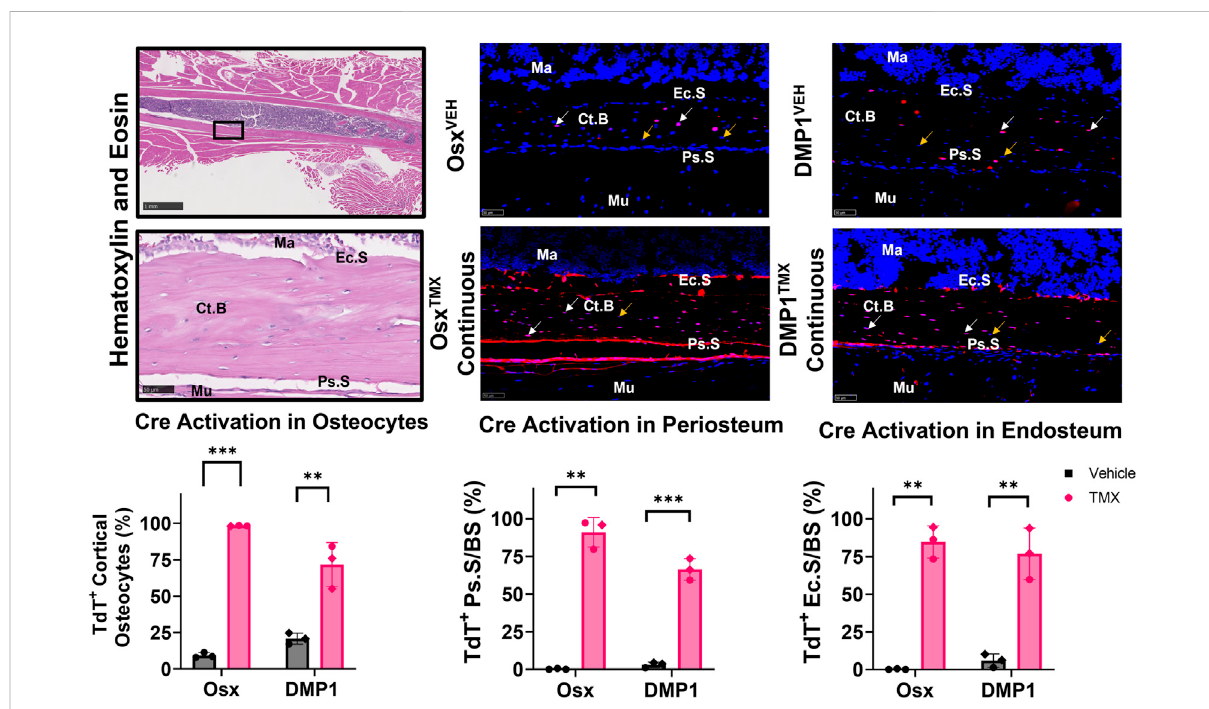
FIGURE 3 Osx Cre_ERT2 has greater diaphyseal cell targeting than DMP1 Cre_ERT2 in uninjuredfemurs (osteocytes and bone lining cells). 2.5X (scale bar 1 mm)and40Ximages(scalebar50 µm)wererandomlytakenfromeachcorticaldiaphysealquadrant(BlackROIs)andusedforquanti fi cationofCre speci fi city from uninjured D7 and D14 continuous TMX and vehicle femurs from each Cre_ERT2 line. TdTomato positive (TdT + ) osteocytes (white arrow) were normalized to total number of osteocytes (TdT + and TdT − cells - orange arrow). TdTomato positive endosteal (TdT + Ec. S) and periostealbonesurface(TdT + Ps.S)werenormalizedtototalbonesurfacelength(BS).Datapresentedasmean±SDwith n =3pergroup.Mousesex of each data point is represented by shape (circle – female; diamond – male). Effects between continuous and vehicle dosing within each inducible Cre line were compared by Unpaired t -test * p < 0.05; ** p < 0.005; *** p < 0.0005 Abbreviations: Ma = Marrow; Ct. B = Cortical bone; Mu = Skeletal